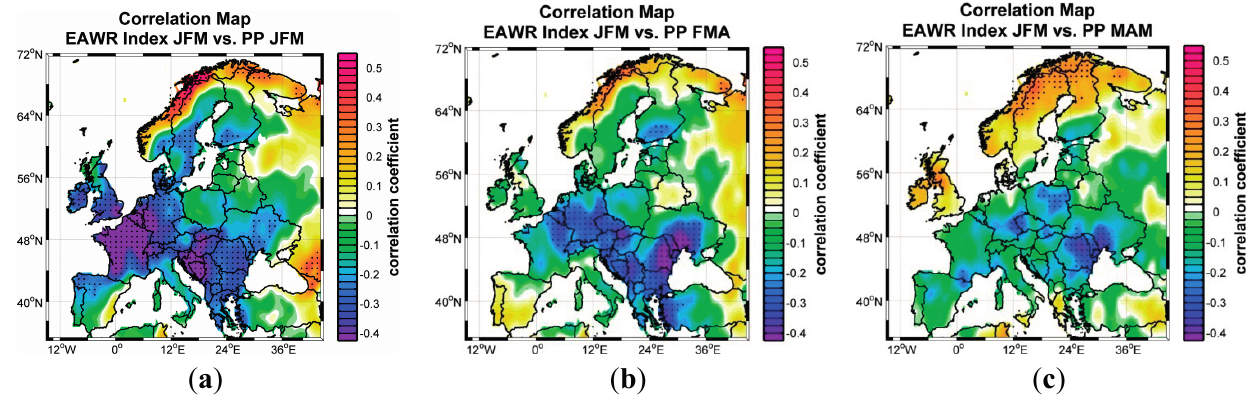
Figure 3. Correlation between the JFM EAWR and CRU T.S. 3.2 Precipitation (PP) for ( a ) January to March (JFM); ( b ) February to April (FMA) and ( c ) March to May (MAM).